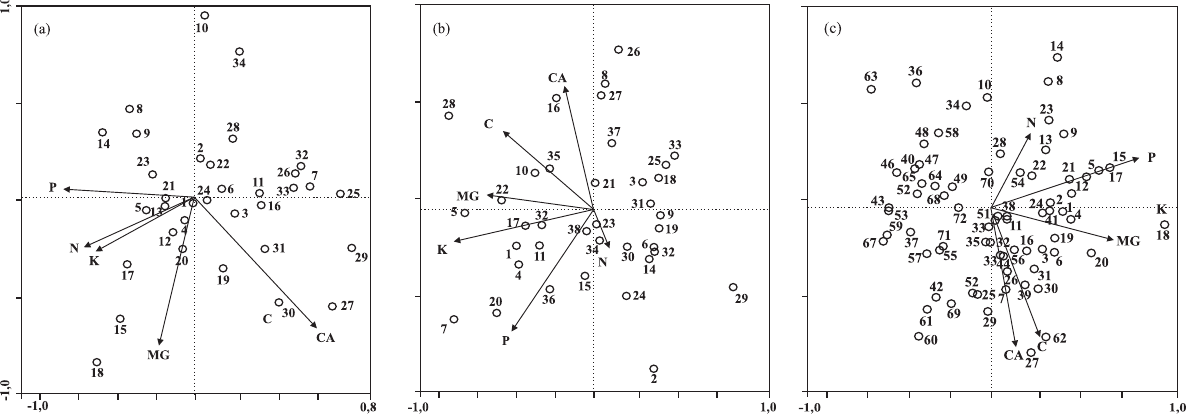
Figura 2. Diagrama de ordenação produzido pela análise de componentes principais do teor de nutrientes e carbono em folhas de espécies encontradas em fragmentos florestais da Mata Atlântica, na região norte-fluminense. (a) fragmento M1; (b) fragmento M2; e (c) fragmentos M1 (espécies de n o 1 a 34) e M2 (espécies de n o 35 a